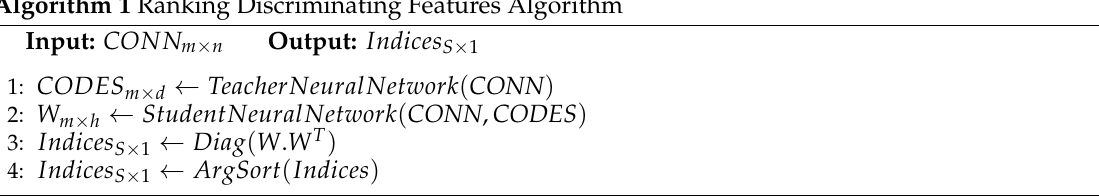
Algorithm 1 Ranking Discriminating Features